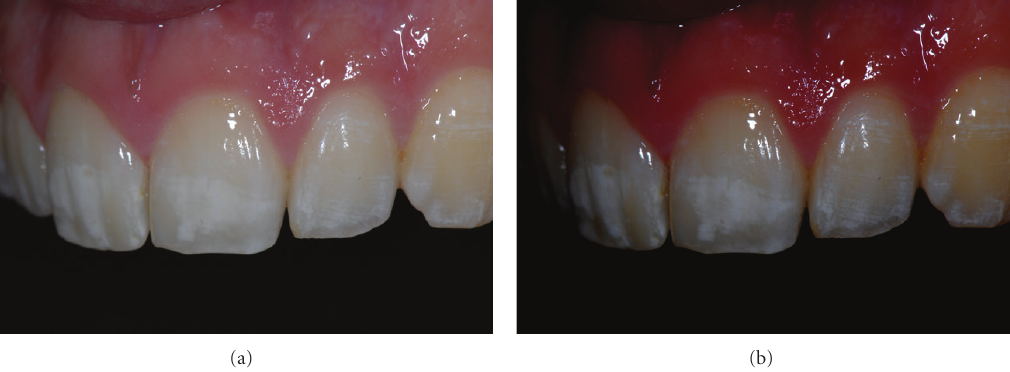
Figure 3: (a) Initial left side picture. (b) Software-modified initial left side picture.